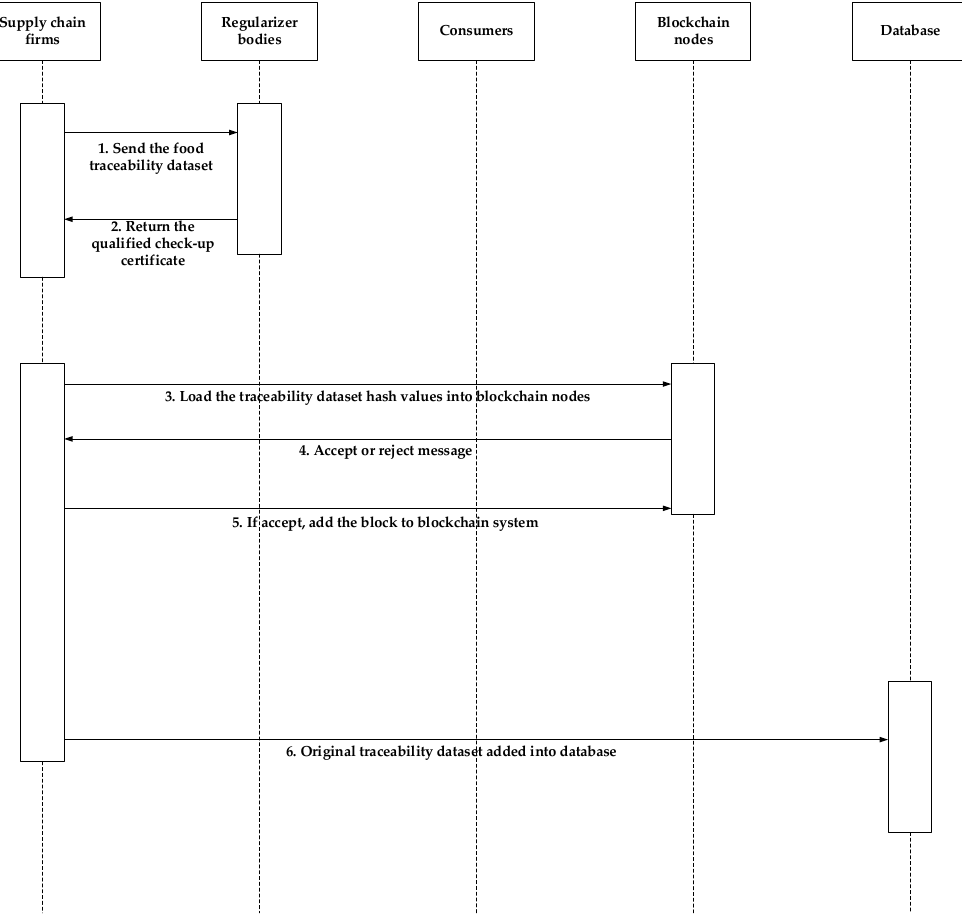
Figure 4. Food traceability blockchain